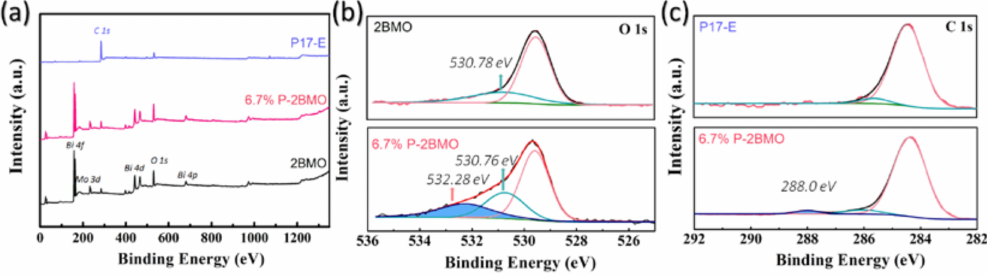
Figure 2. X-ray photoelectron spectroscopy (XPS) spectra of 2BMO, 6.7% P-2BMO and P17-E: ( a ) survey spectra, ( b ) O 1s and ( c ) C